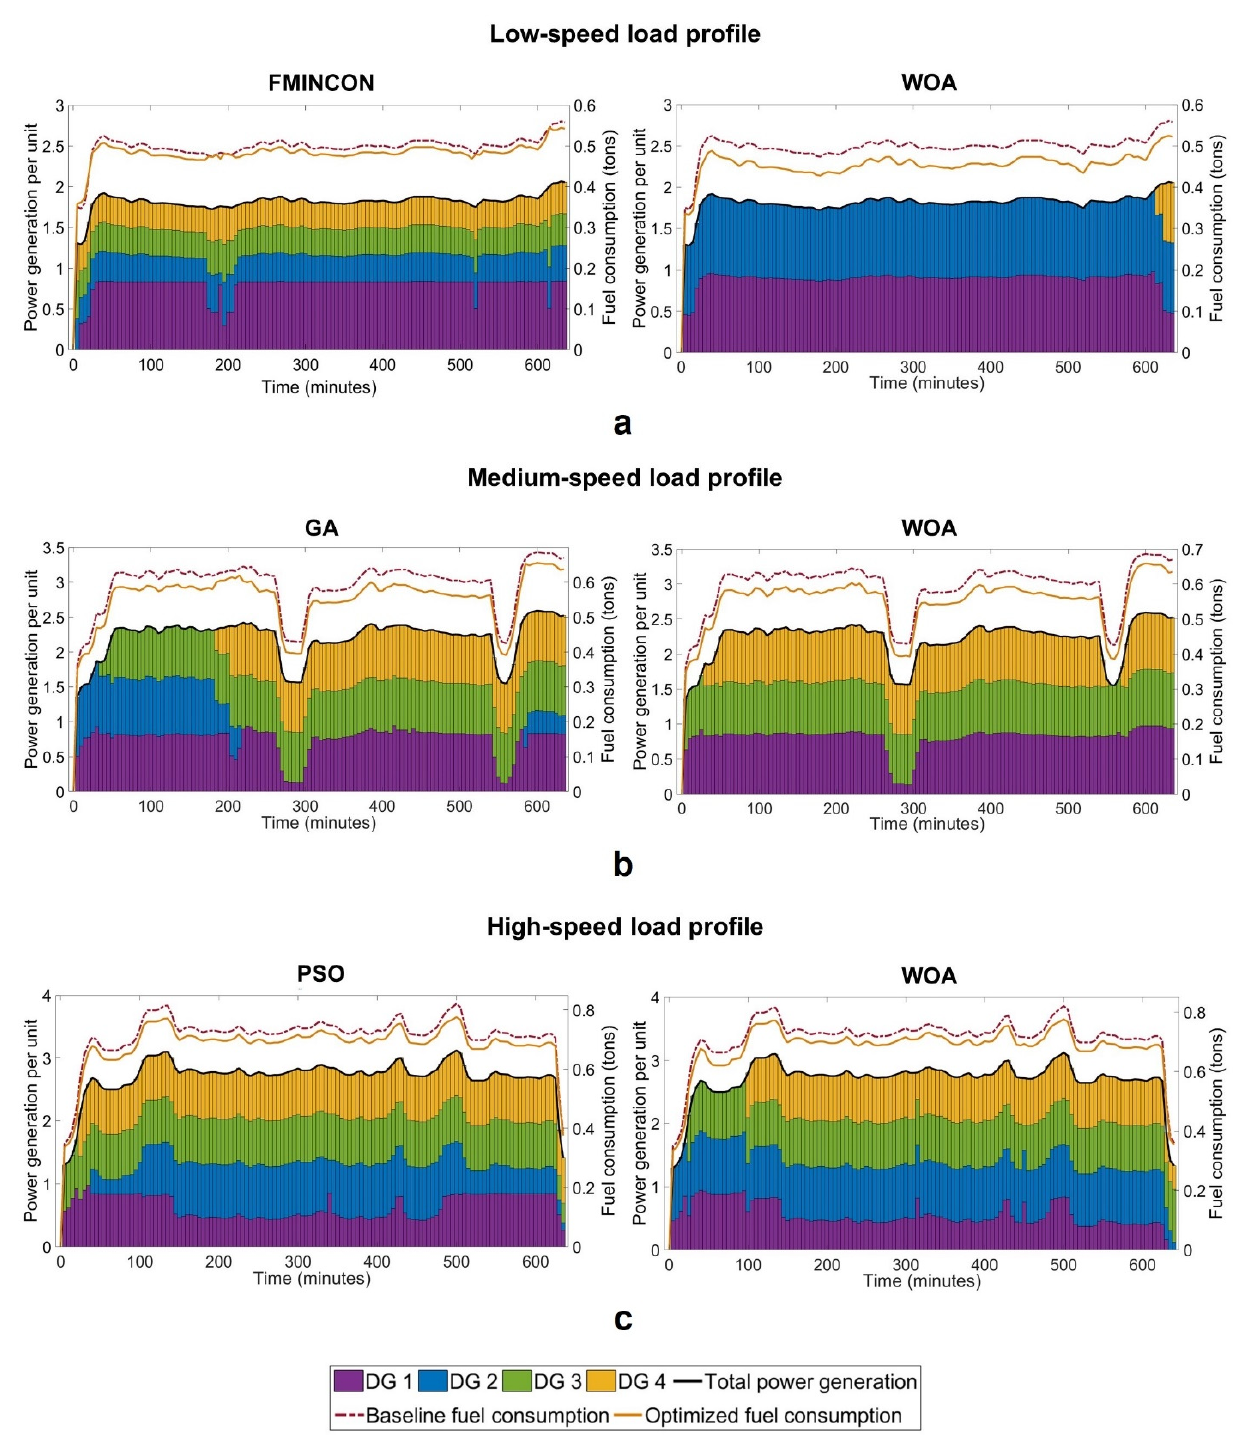
Figure 11. Comparison of optimization for the 4-DG system: ( a ) FMINCON and WOA with low-speed profile ( b ) GA and WOA with medium-speed profile ( c ) PSO and WOA with high-speed profile.